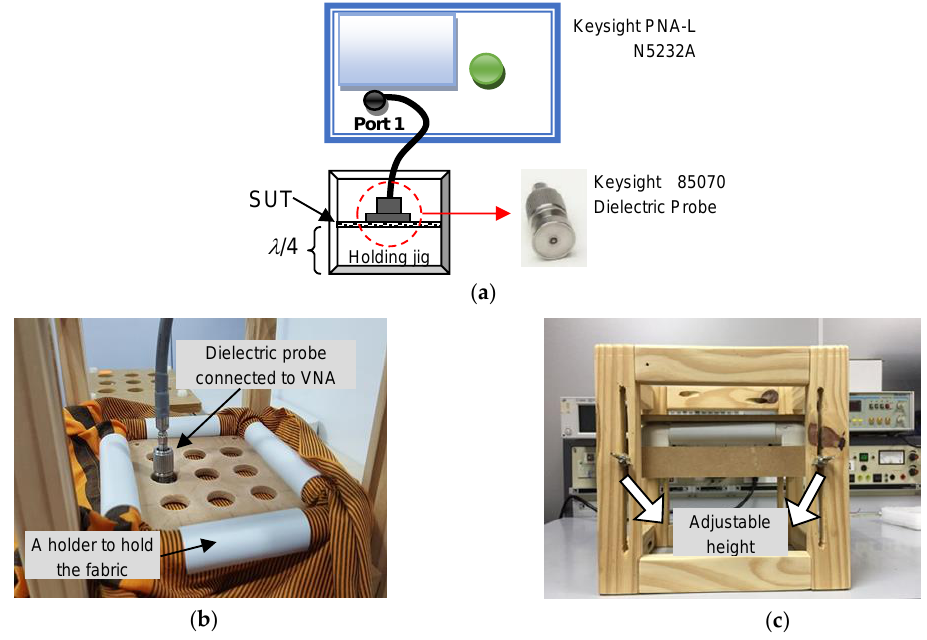
Figure 5. Measurement of dielectric properties: ( a ) Equipment arrangement which consists of dielectric probe, network analyzer and holding jig; ( b ) Customized jig with holes and holders to ensure consistent readings and to control fabric stiffness; ( c ) Adjustable height feature to allow measurement of many samples at various operational frequencies. VNA, vector network analyzer; SUT, sample-under-test.